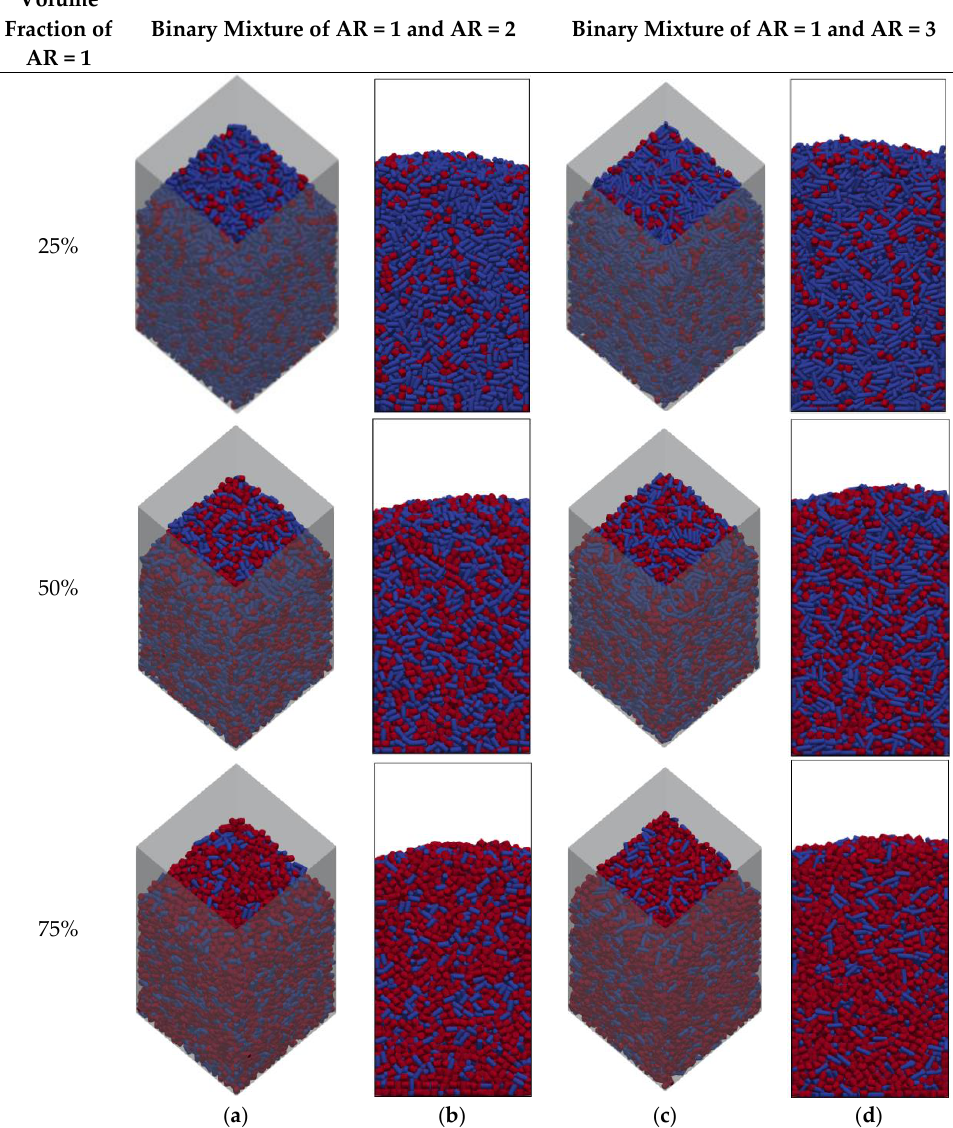
Figure 1. Visualization of binary mixtures of cylinders simulated using DEM: ( a , c ) overall bed view and ( b , d ) front view (red particles of AR = 1, blue particles of AR = 2 and AR = 3). The projected positions of particles in the horizontal plane are shown in Figure 3.